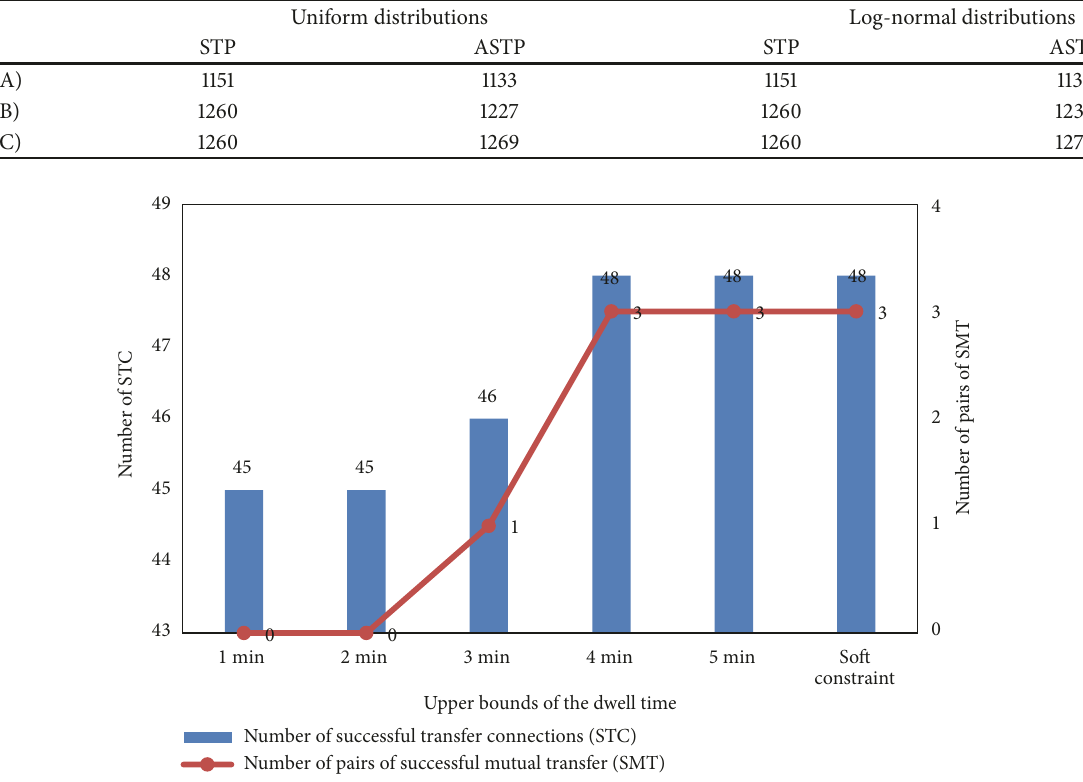
Figure 5: Effect of the dwell time on mutual